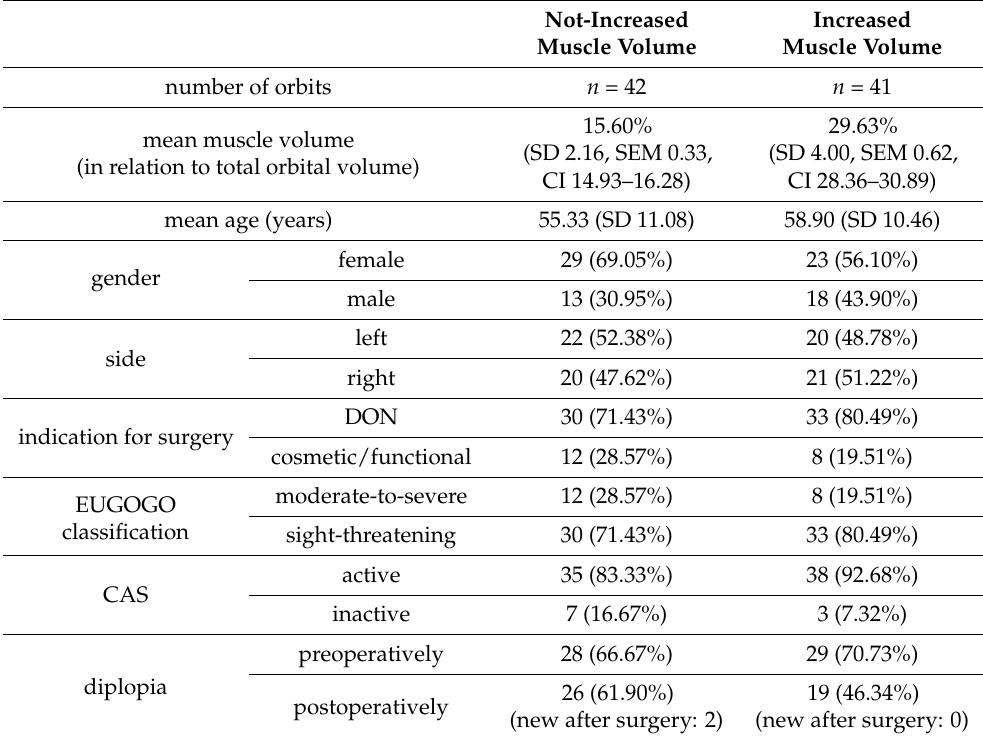
Table 1. Classification and demographic data of the “not-increased orbital muscle volume” and the “increased orbital muscle volume” group.